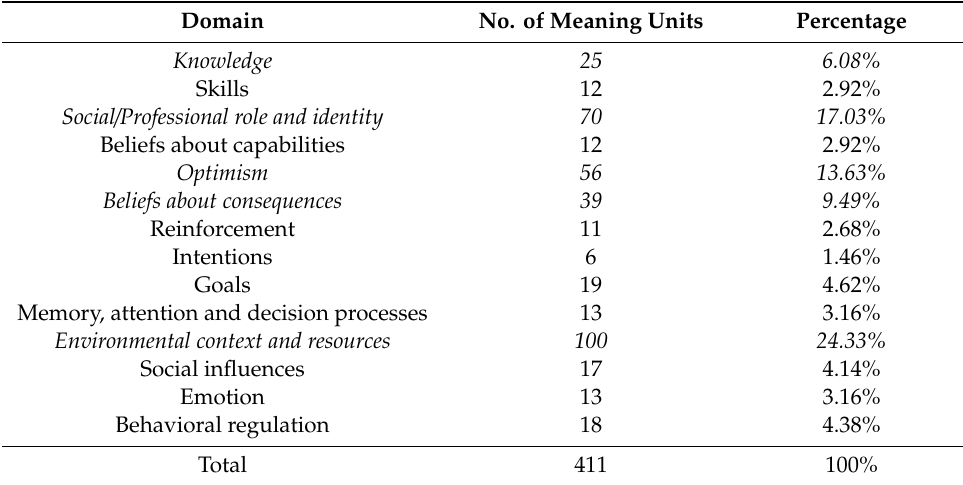
Table 2. Distribution of meaning units across Theoretical Domains Framework domains.